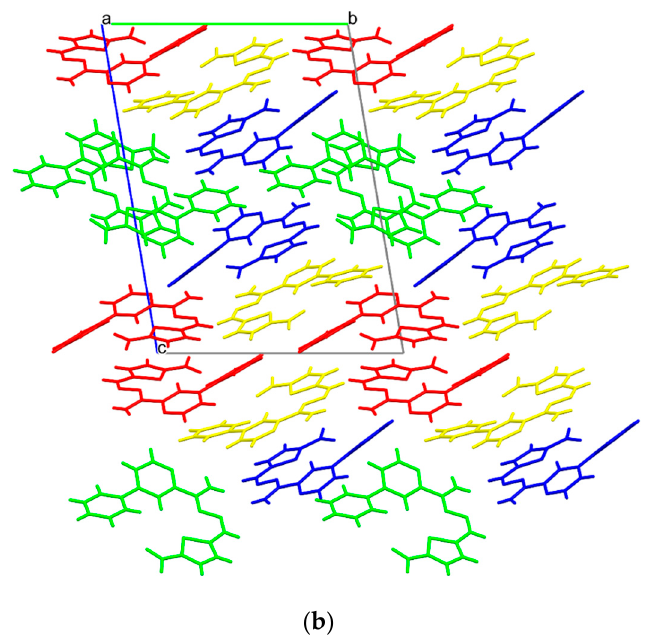
Figure 8. ( a ) Intermolecular hydrogen bonds in 3b . ( b ) The packing of molecules in 3b (a, b, c–unit cell).